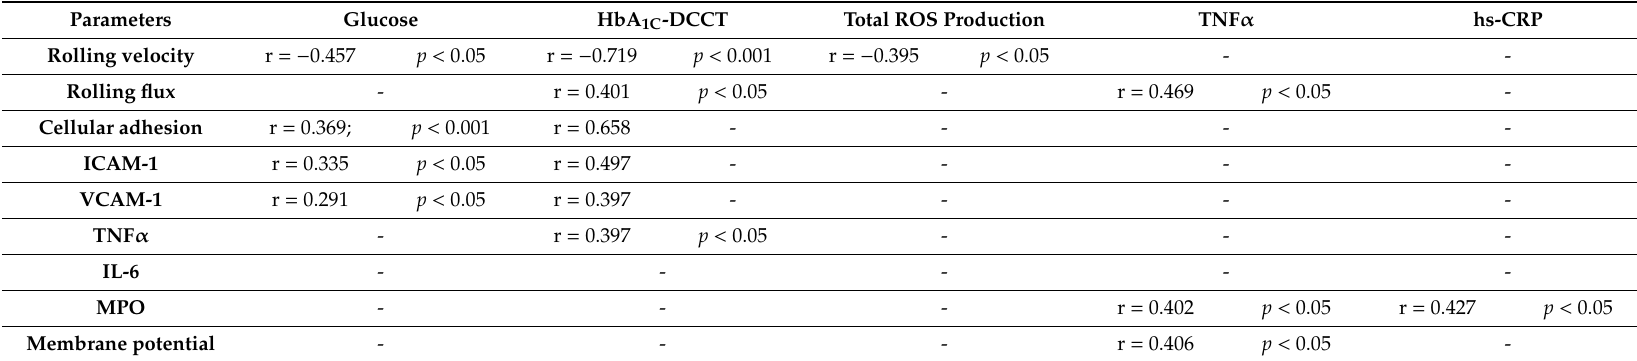
Table 2. Correlations between glucose blood, ROS production, leukocyte–endothelium interaction and inflammation in study population.